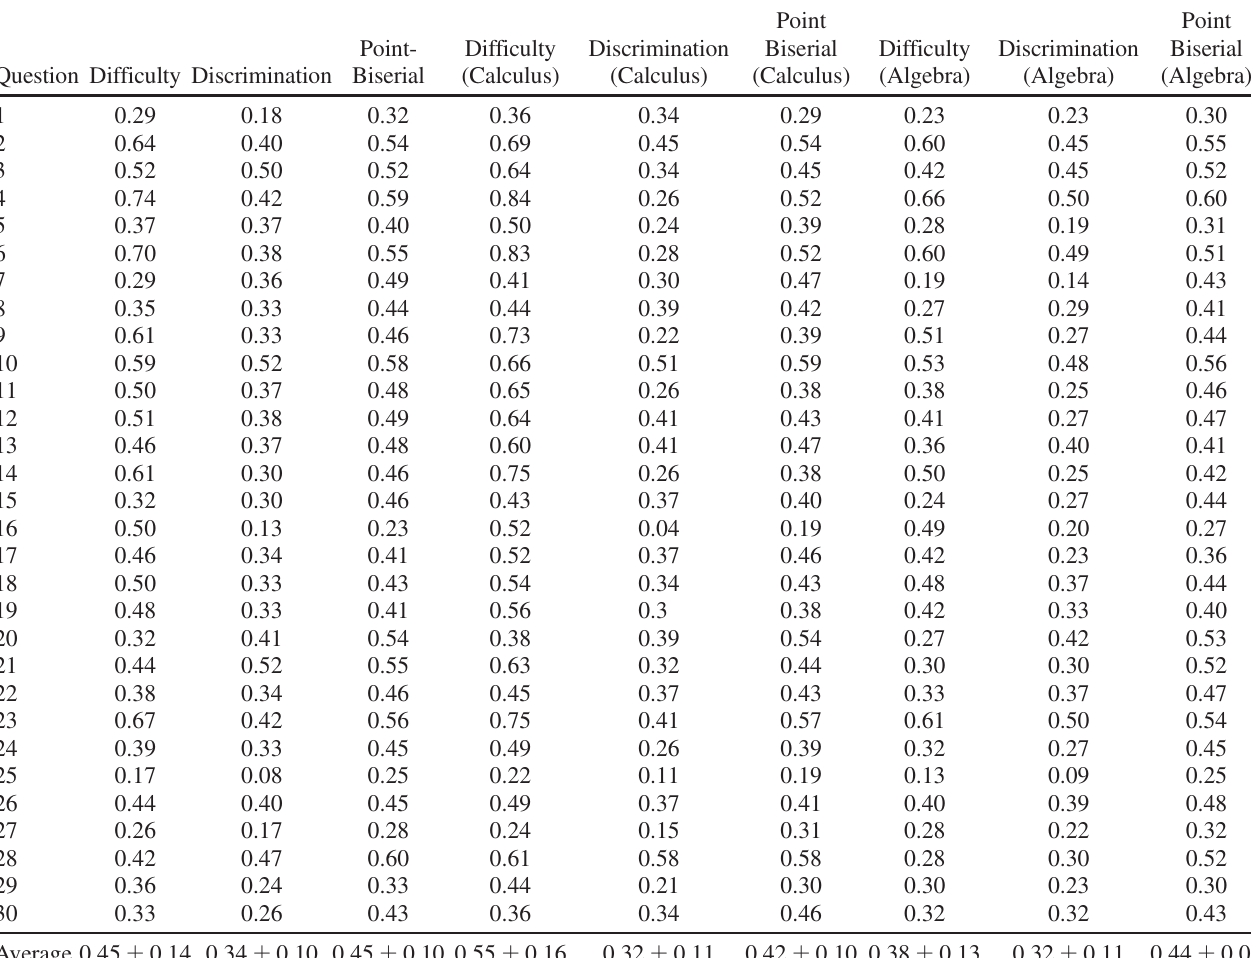
TABLE II. Post-test individual question item difficulty, discrimination, and point-biserial coefficient.